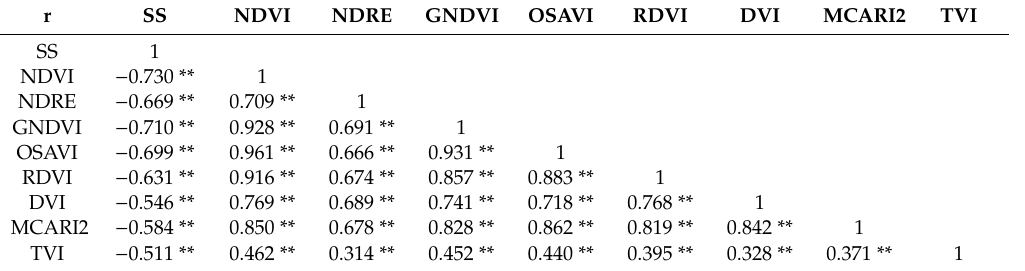
Table 2. Correlation coe ffi cient between vegetation index and soil